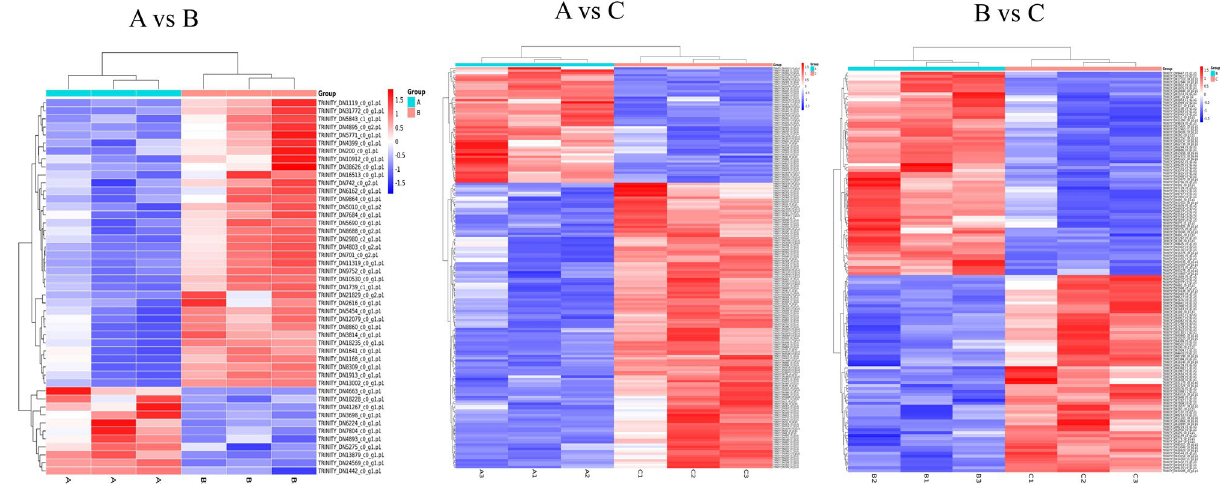
Figure 3. Hierarchical clustering analysis for differentially expressed proteins under salt stress. Note : Blue shading reflects the degree of decrease in protein expression, while red shading reflects the degree of increase in protein expression.